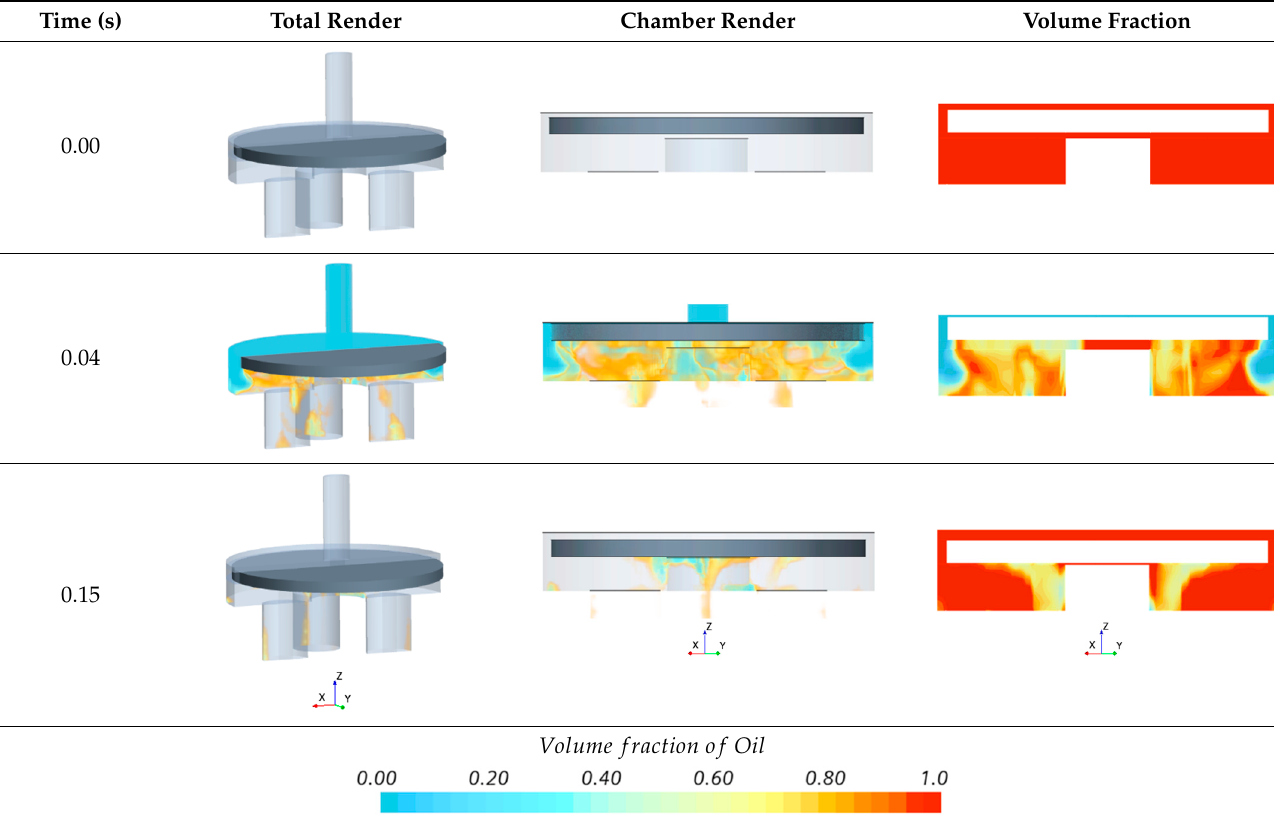
16 of 24 Figure 14. The mesh’s behavior in three different plate positions: at the initial stage, with the water inlet (closed position), and finally with the oil inlet (open position). The Figure 14 shows that the mesh cells could not disappear or have an area equal to zero because that would generate an error in the discretization. On the other hand, the cells that closed horizontally to the side of the plate did not suffer any deformation; this was defined to maintain the plate’s geometry without variations. Thus, the deformation was implemented only in the vertical direction. RCP internal motion Mainly the DFBI model was expected to act differently with water and oil. Specifi- cally, the plate had to rise in the presence of water while the plate sunk with oil. Further- more, according to Askvik and Johannessen, the plate oscillated when the valve closed, which was expected to be emulated in the numerical model [4]. However, it is essential to